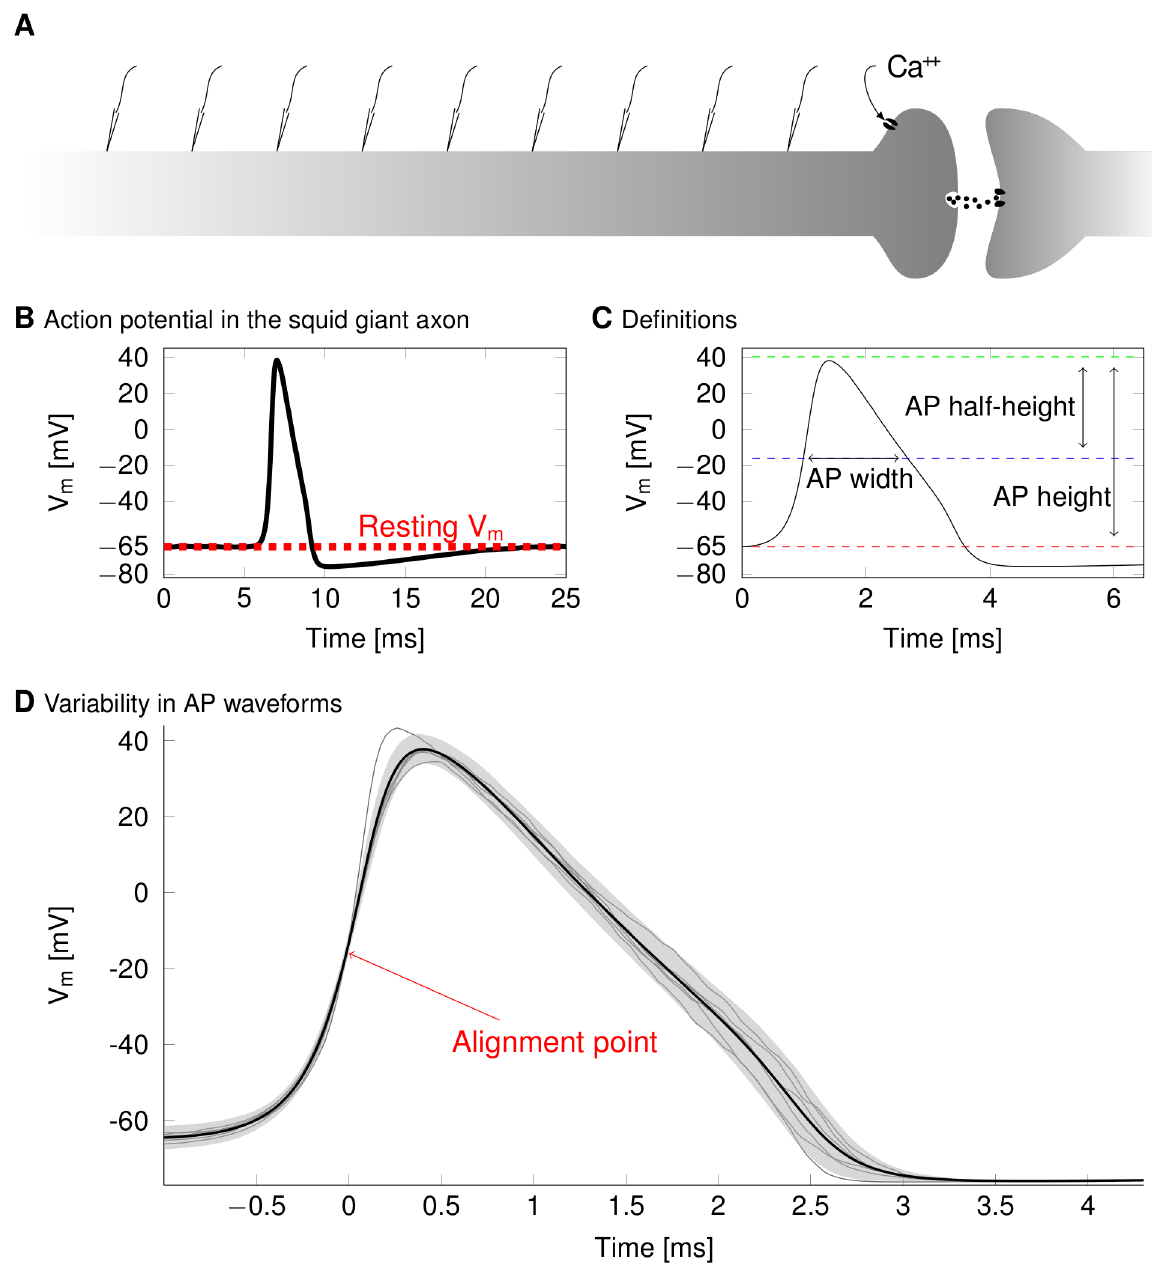
Figure 1. Definitions and methods. (A) We record membrane potential and ionic currents at regularly placed points along the axon, and compare the (B) shape of the AP waveforms (black) and the resting membrane potential (dashed red). (C) Action potential features are determined individually for each AP. The amplitude of the AP is defined as the maximum membrane potential. The width is the delay between the crossings of the mid- height level. (D) AP shape fluctuations. Due to channel noise, APs triggered in an identical fashion will have different shapes across trials. Here APs in a 0.2 m m diameter axon from 5 trials out of 250 are superimposed. The point at which the membrane potential crossed the half-height line is used to align APs.